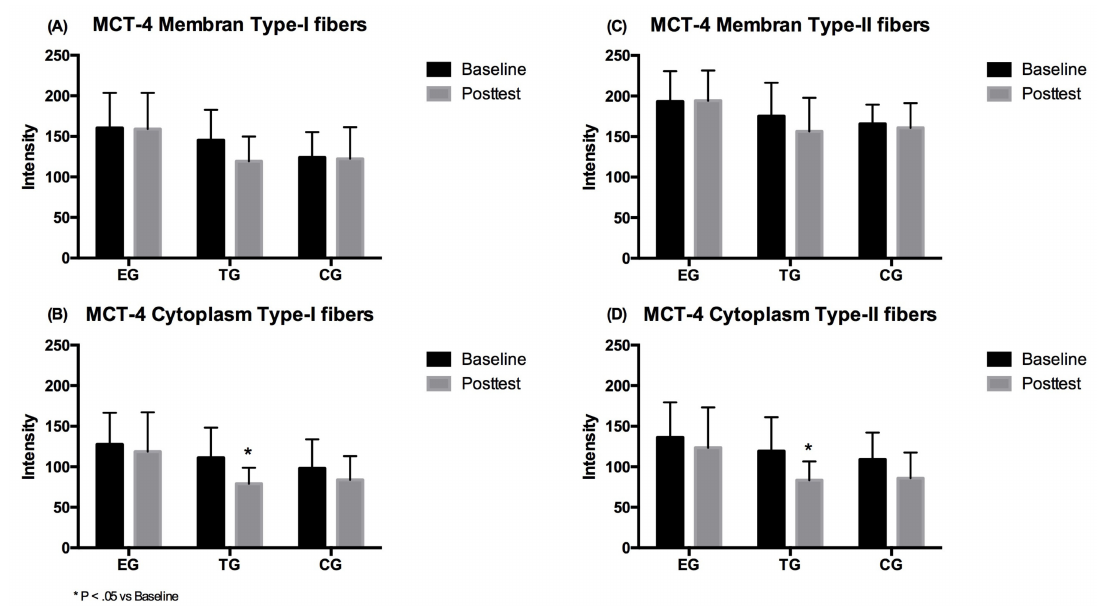
Figure 4. MCT-4 density in type-I fiber ( A ) membrane and ( B ) cytoplasm, and in type-II fiber ( C ) membrane and ( D ) cytoplasm for EMS-Group (EG), Training-Group (TG) and Control-Group (CG) measured before (Baseline) and after the 7 weeks intervention period (Posttest). Values are presented in means ±